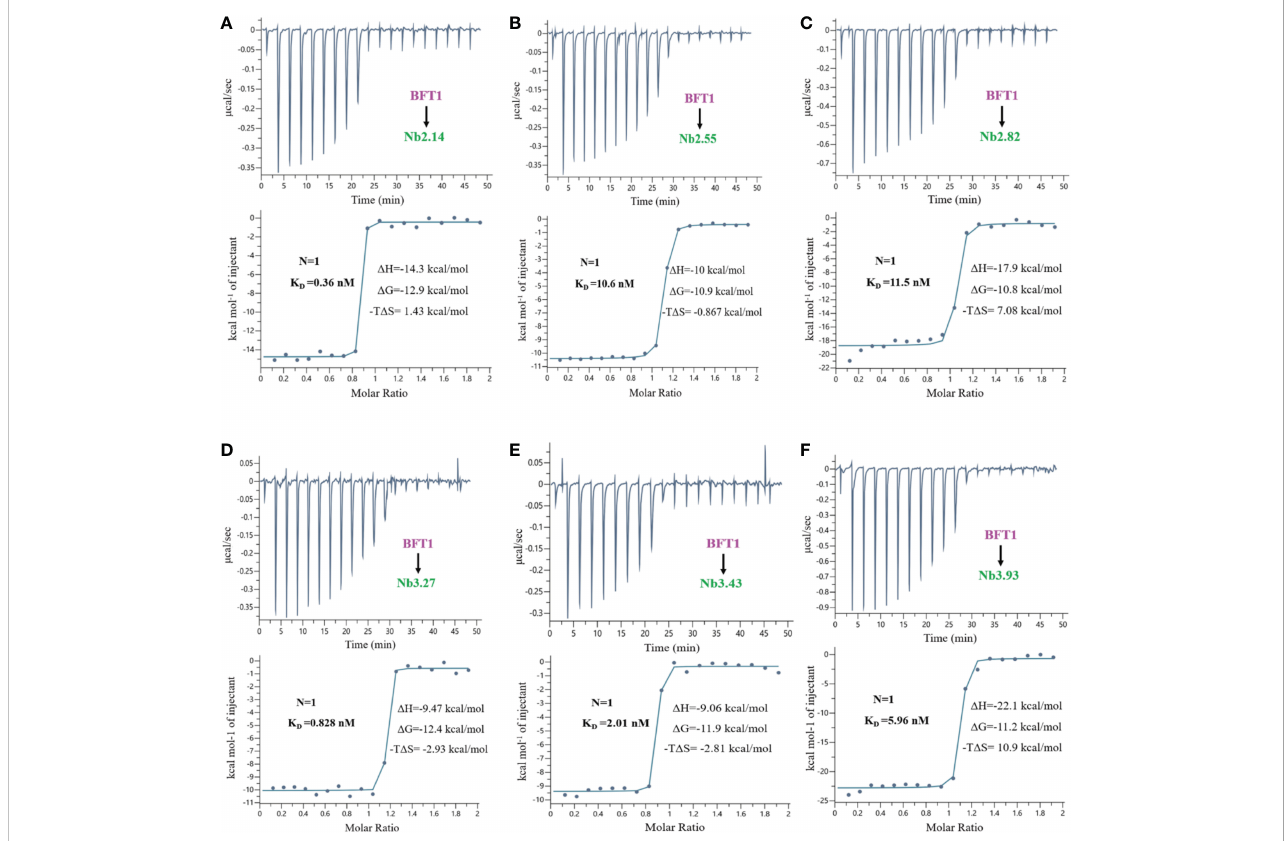
FIGURE 4 The isothermal titration calorimetery of BFT1 and nanobody. There were 6 nanobodies with high af fi nity of BFT1, (A) Nb2.14 (B) Nb2.55 (C) Nb2.82 (D) Nb3.27 (E) Nb3.43 (F) Nb3.93. Dissociation constant (K D ), stoichiometry (N), enthalpy ( D H), entropy ( D S) and Gibbs free energy ( D G) are